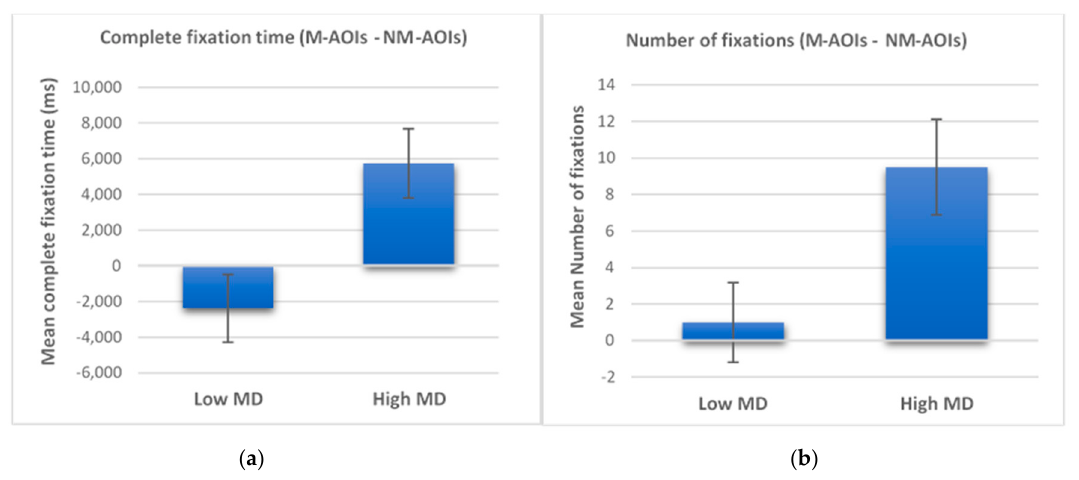
Figure 3. Differences between men with high and low muscularity dissatisfaction (MD) in mean complete fixation time (in milliseconds; ms) and mean number of fixations on muscle (M)-related vs. nonmuscle (NM)-related areas of interest (AOIs). Error bars represent standard error of the mean (SEM). ( a ) Complete fixation time; ( b ) Number of fixations.